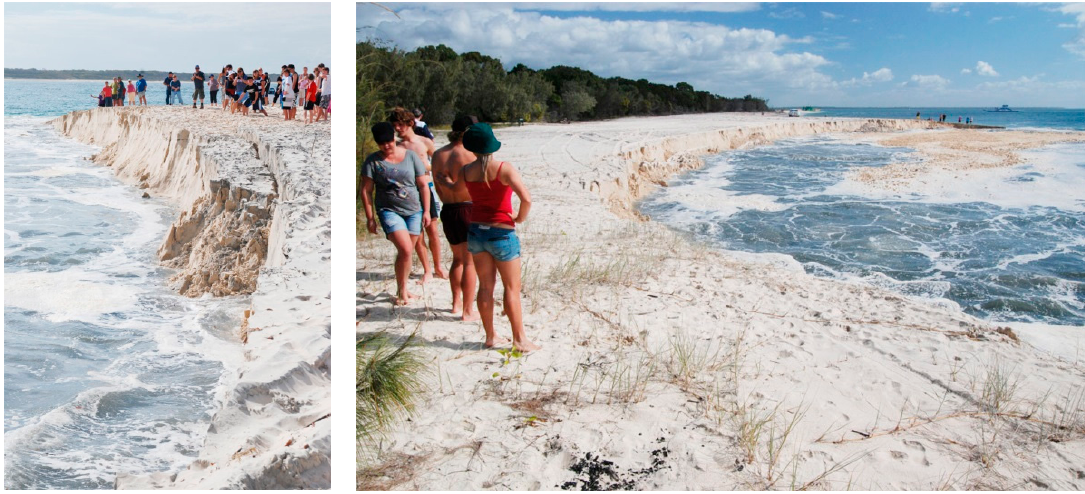
Figure 2. An active RBF even at Inskip Point, Queensland, Australia, 2011. Photos: Jim Wyers, Gympie Times.